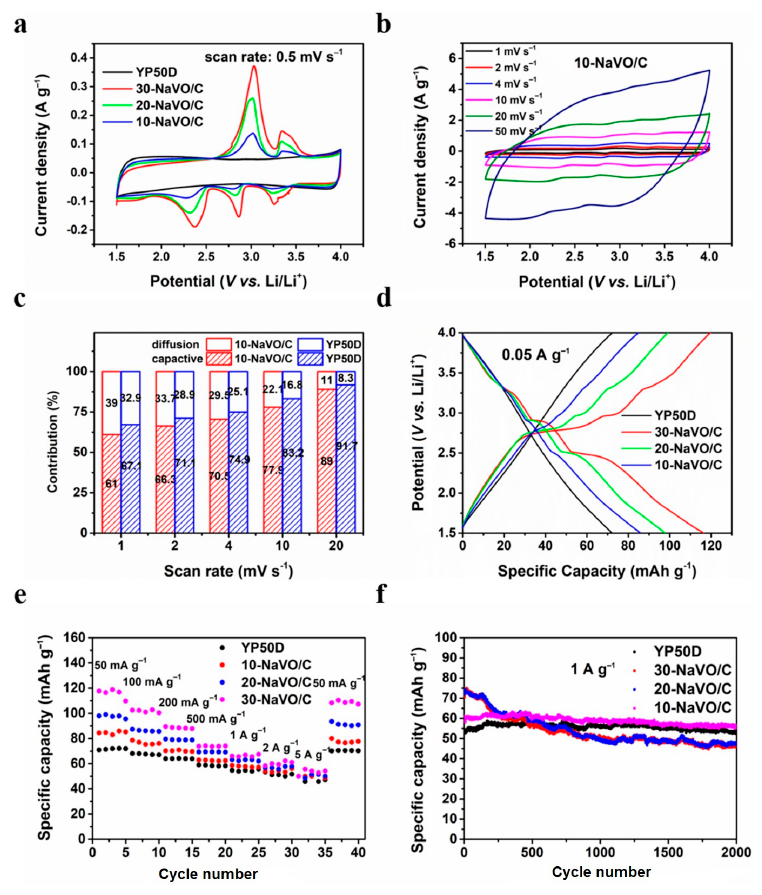
Figure 3. Electrochemical performances of YP50D and the NaVO/C hybrids in half-cell tests from 1.5 to 4 V. ( a ) Cyclic voltammetry (CV) curves of all the samples at a scan rate of 0.5 mV s − 1 ; ( b ) CV curves of 10-NaVO/C at different scan rates between 1 and 50 mV s − 1 ; ( c ) contribution ratios of the diffusion-controlled faradaic process and capacitive process for 10-NaVO/C; ( d ) galvanostatic charge/discharge (GCD) profiles of all the samples at a current density of 0.05 A g − 1 ; ( e ) rate performance at various current densities; ( f ) cycling behavior at 1 A g − 1 for 2000